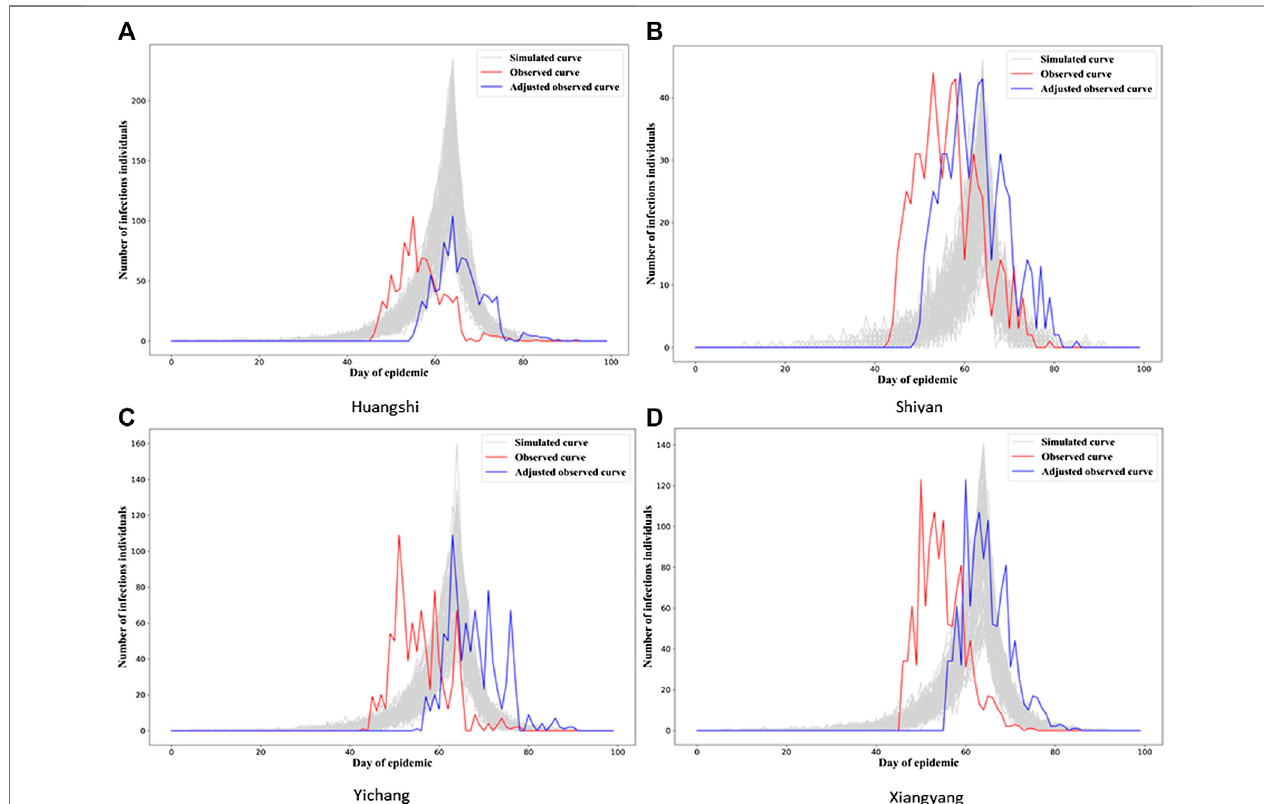
FIGURE 4| Observed and simulated epidemic curves under fi nal model for four cities in Hubei (other 12 cities in Figures 5 , 6 ; for Wuhan, see Figure 3 ).Real data shown in red; shifted real data accounting for potential differences in delays to reporting in different cities shown in blue; dark gray curves represent 70% of curves simulated from the fi nal model closest to the true